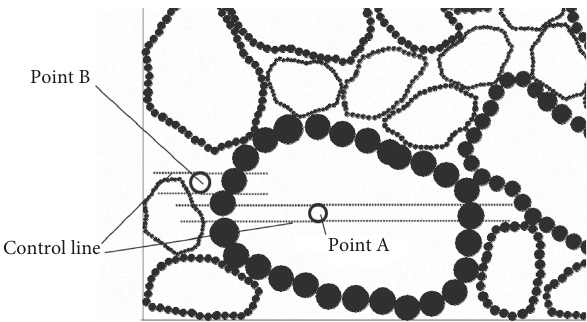
Figure 8: Distinguishing the position of mastic balls between two particle clumps (inside or outside the